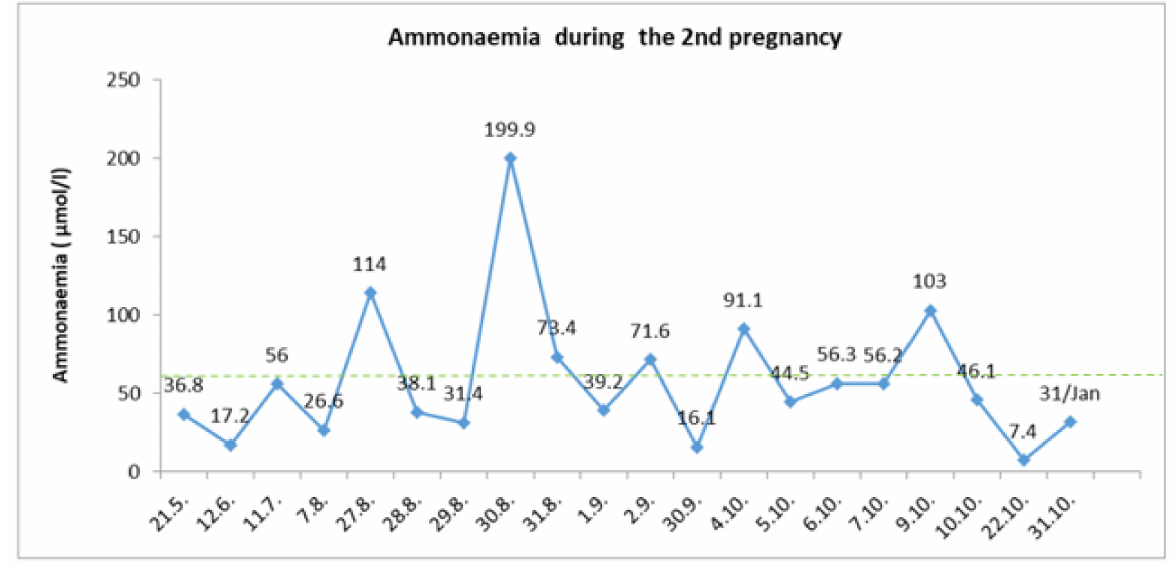
Figure 4. Ammonia levels during the second pregnancy were more stable. The patient was hospi- talized for the first time at the end of the 2nd trimester from 27 August to 2 September for signs of fatigue and nausea. Intravenous energy support and diet adjustment were required. In October 2019, the patient was hospitalized for a perinatal management assessment when she missed her treatment. This was followed by metabolic decompensation and hospitalization was necessary for the need of infusion